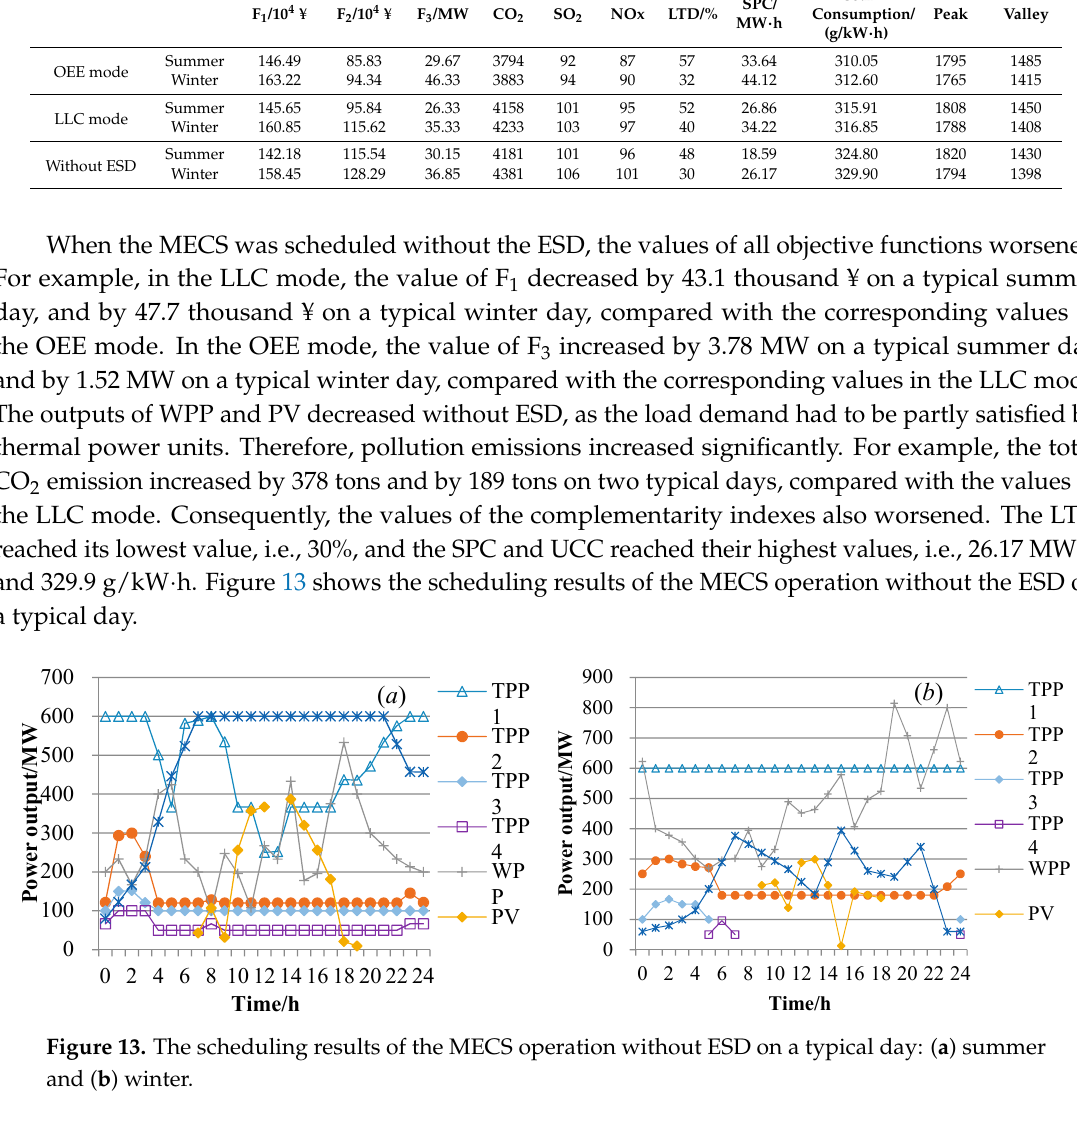
Table 5. The comparative results of MECS scheduling under different operation scenarios. Objective Function Scene